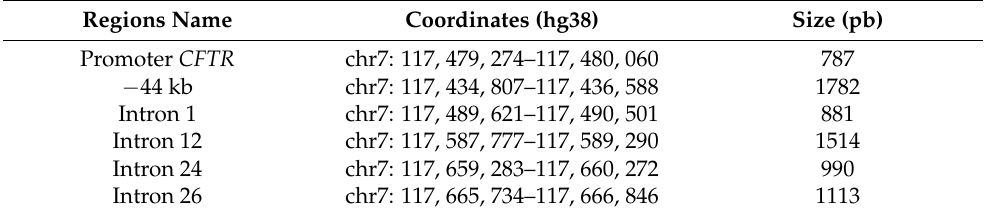
Table A1. Regions of CFTR candidate cis -regulatory elements cloned in pGL3-Basic Vector for luciferase reporter